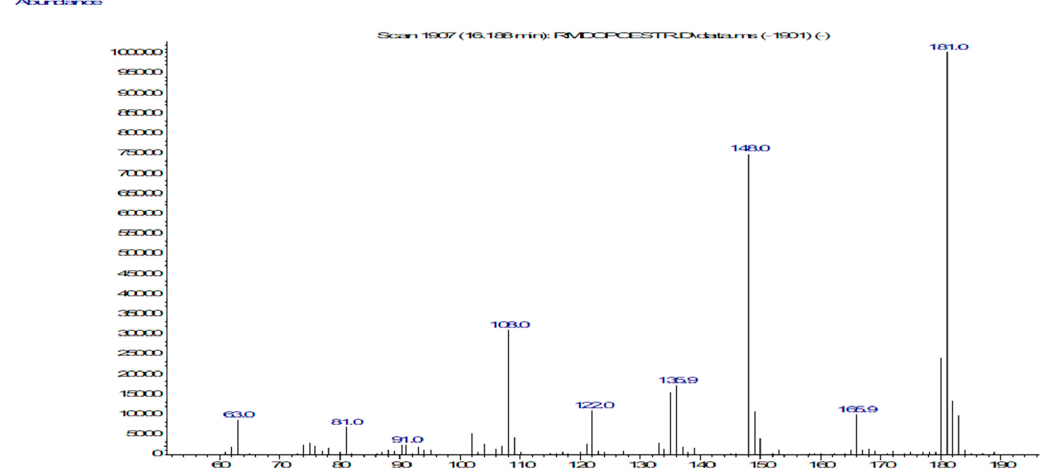
Figure A5. MS spectrum of 2-(methyl mercapto)benzothiazole r.t 16,17 min.